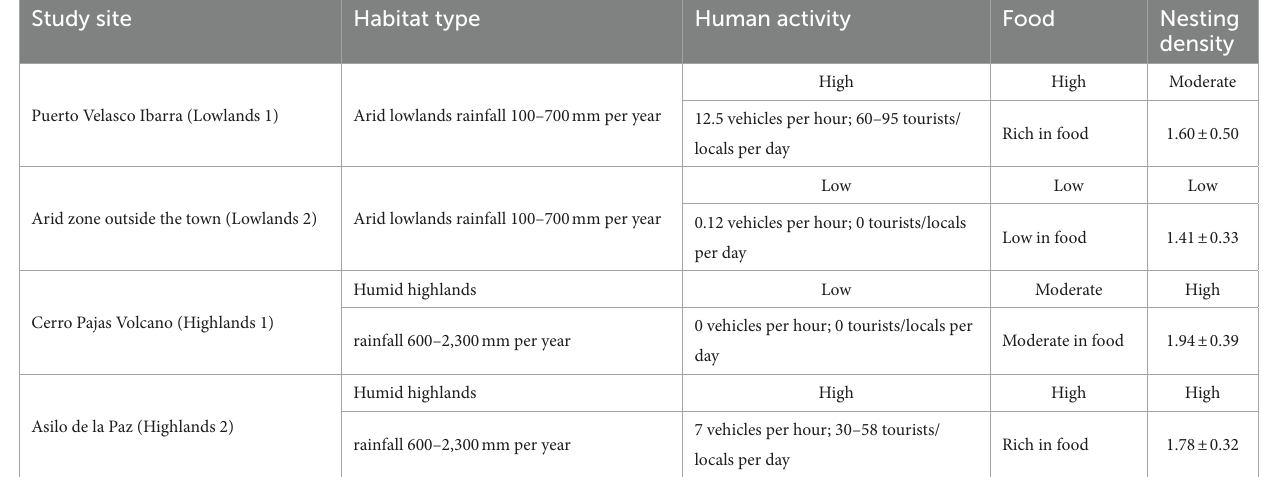
TABLE 1 Summary of the differences in habitats, levels of human activity, food, and small ground finch nesting densities (average number of active nests within 20 m) across our four study sites. Study